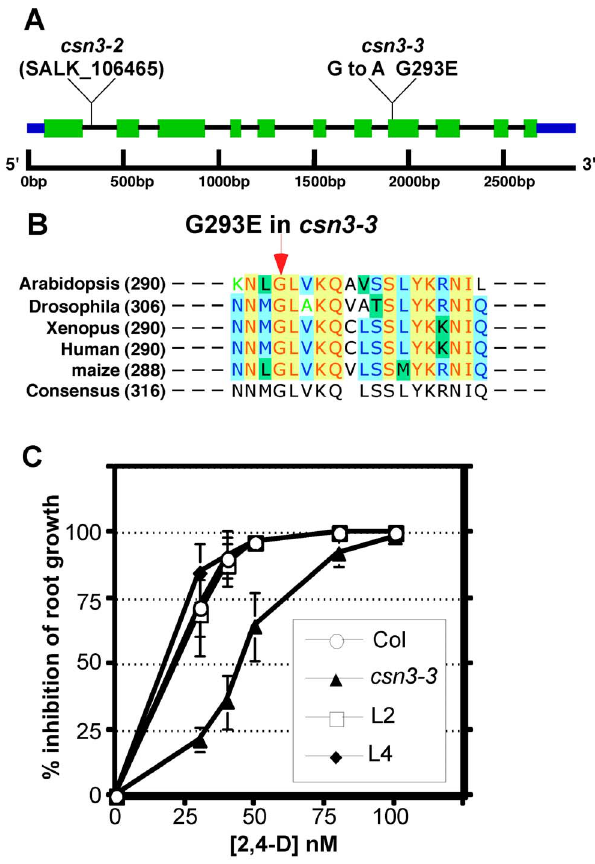
Figure 1. csn3-3 is a weak missense allele of CSN3 . ( A ) Schematic representation of the Arabidopsis CSN3 locus. Positions of the csn3-3 missense mutation and previously described csn3-2 T-DNA insertion are indicated. ( B ) Sequence alignment around the csn3-3 mutation among the CSN3 homologs from Arabidopsis thaliana , Drosophila melanogaster , Xenopus laevis , Homo sapiens (Human) and Zea mays (maize). The arrow indicates the position of the csn3-3 G293E missense mutation. ( C ) Complementation of the csn3-3 auxin resistance phenotype by introduction of a genomic CSN3 transgene. L2 and L4 are two independent csn3-3 [ gCSN3 ]